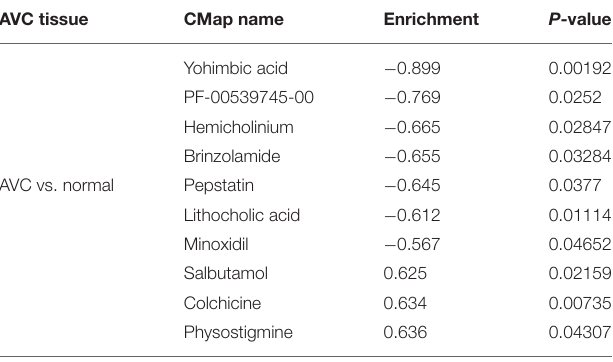
TABLE 2 | List of the 10 most significant small molecule drugs that can reverse the calcified status of AVC. AVC